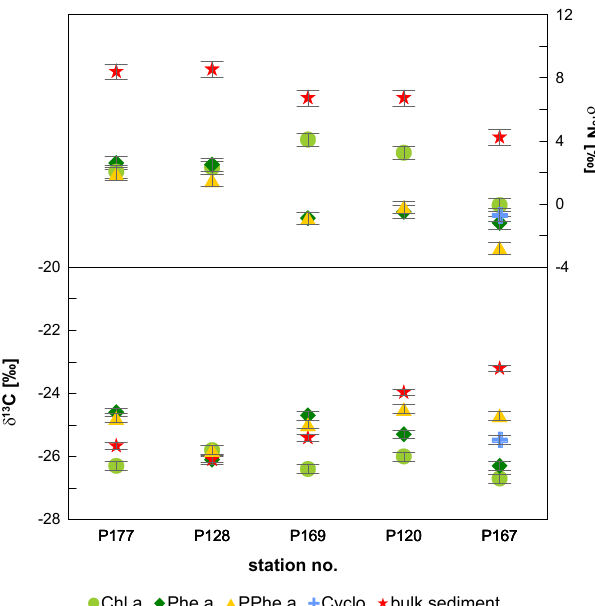
Fig. 2. Stable nitrogen and carbon isotopic compositions ( δ 13 C and δ 15 N) of purified chloro- and pheopigments Error bars give 1 σ - analytical uncertainty. Chl- a : chlorophyll- a , Phe- a : pheophytin- a , PPhe- a : pyropheophytin- a , Cyclo: 13 2 ,17 3 -cyclopheophorbide- a -